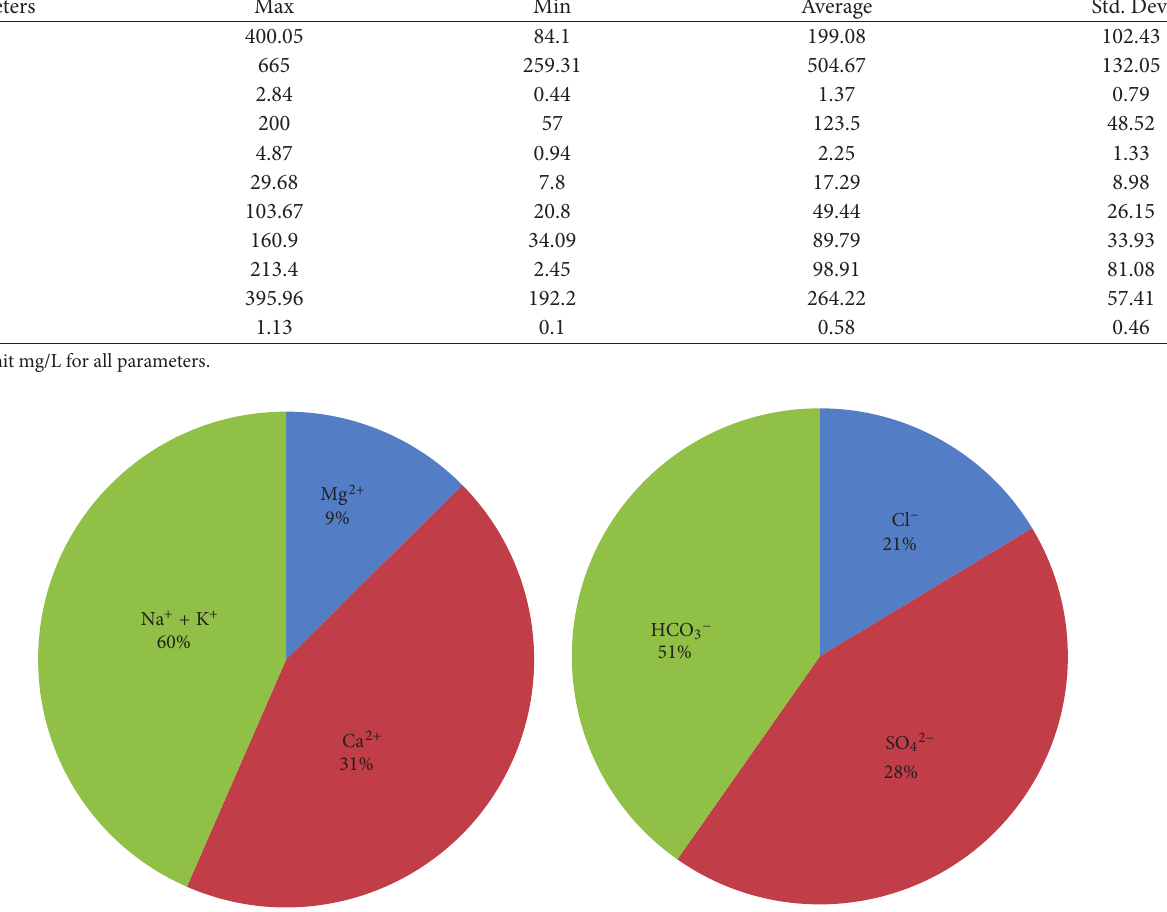
F 1: Pipe chart of groundwater ions